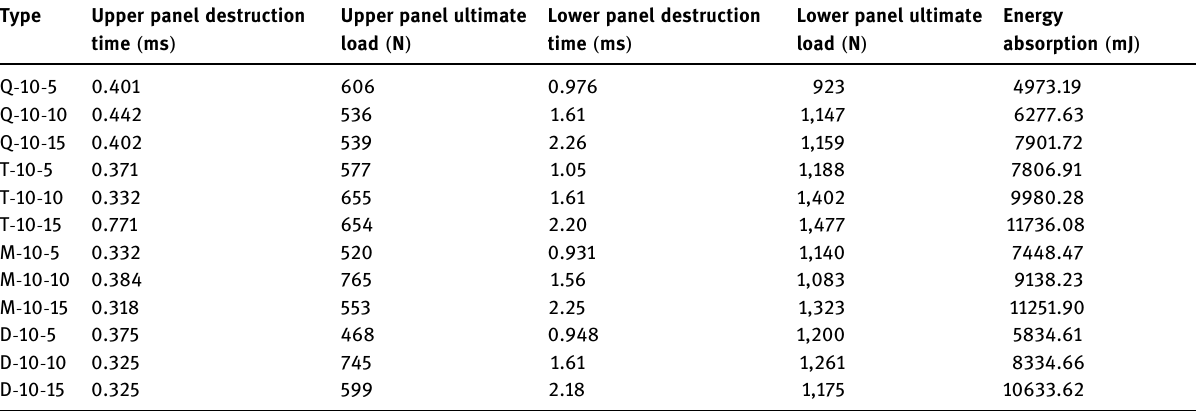
Table 3: In fl uence of grid height on ultimate load and energy parameters